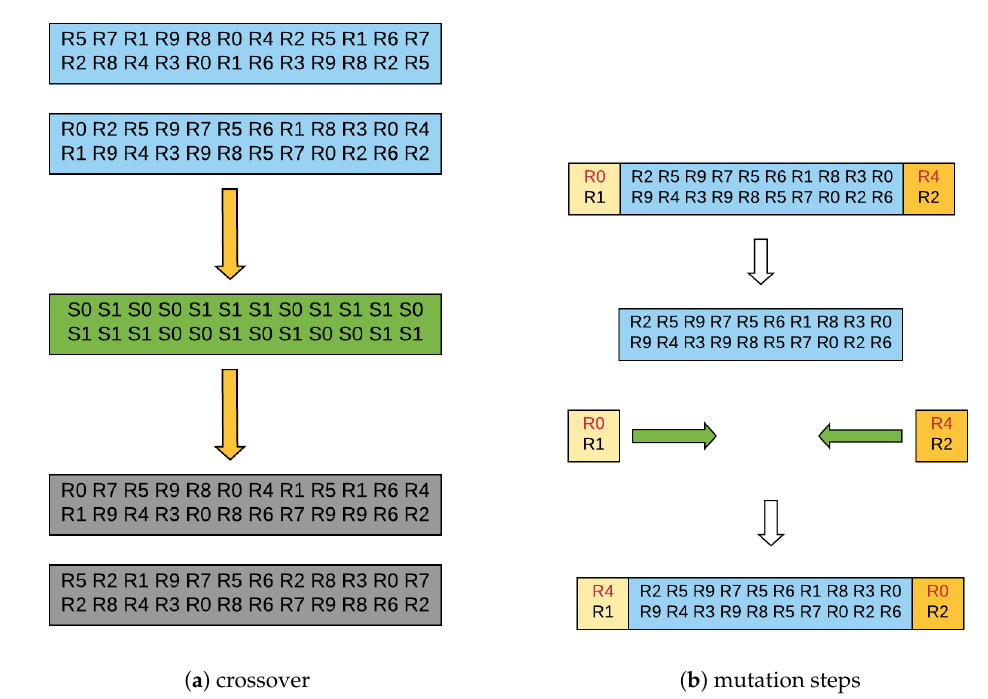
Figure 2. GA operations.